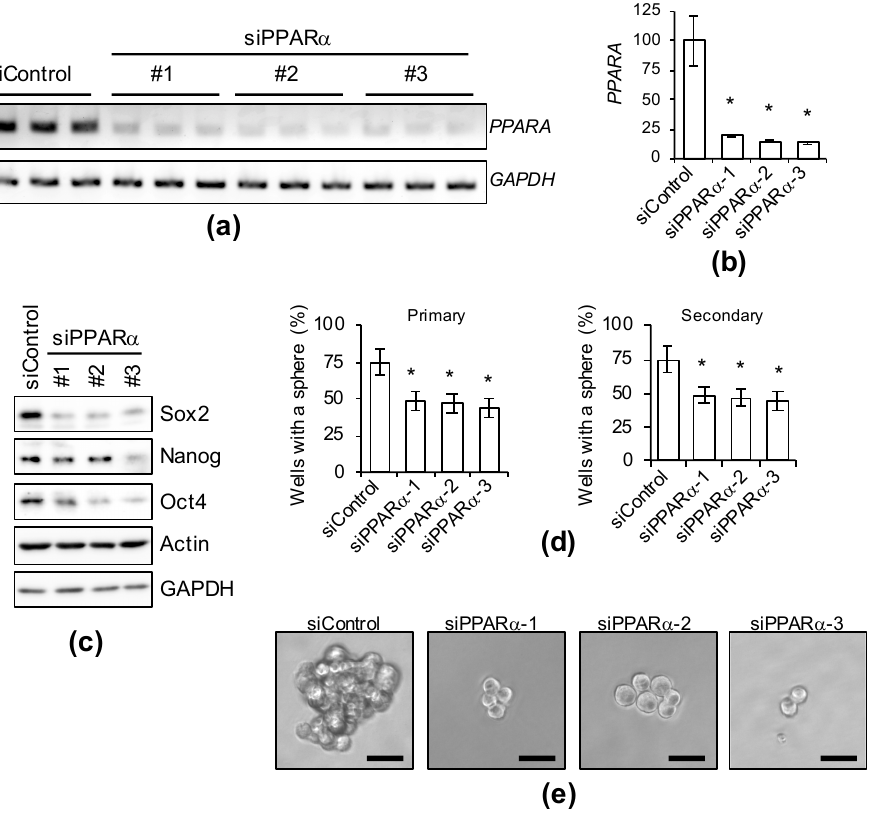
Figure 5. Genetic silencing of PPAR α causes the loss of stemness in PANC-1 CSCs. PANC-1 CSCs were transiently transfected with siRNA against PPAR α or control siRNA (siControl). After four days, the transfected cells were subjected to each analysis as described below. ( a – d ) Cells treated as indicated were subjected to agarose gel electrophoresis ( a ), quantification of PCR analyses by densitometry ( b ), immunoblot analyses ( c ), or serial sphere formation analyses ( d ). The values are presented as the means ± SDs from triplicate samples of a representative experiment. Similar results were obtained from two independent biological replicates. ( e ) Representative photographs of primary spheres are shown. Similar results were obtained from three independent biological replicates. Bar: 50 µ m. * p < 0.05 vs. control siRNA-transfected cells by Dunnett’s